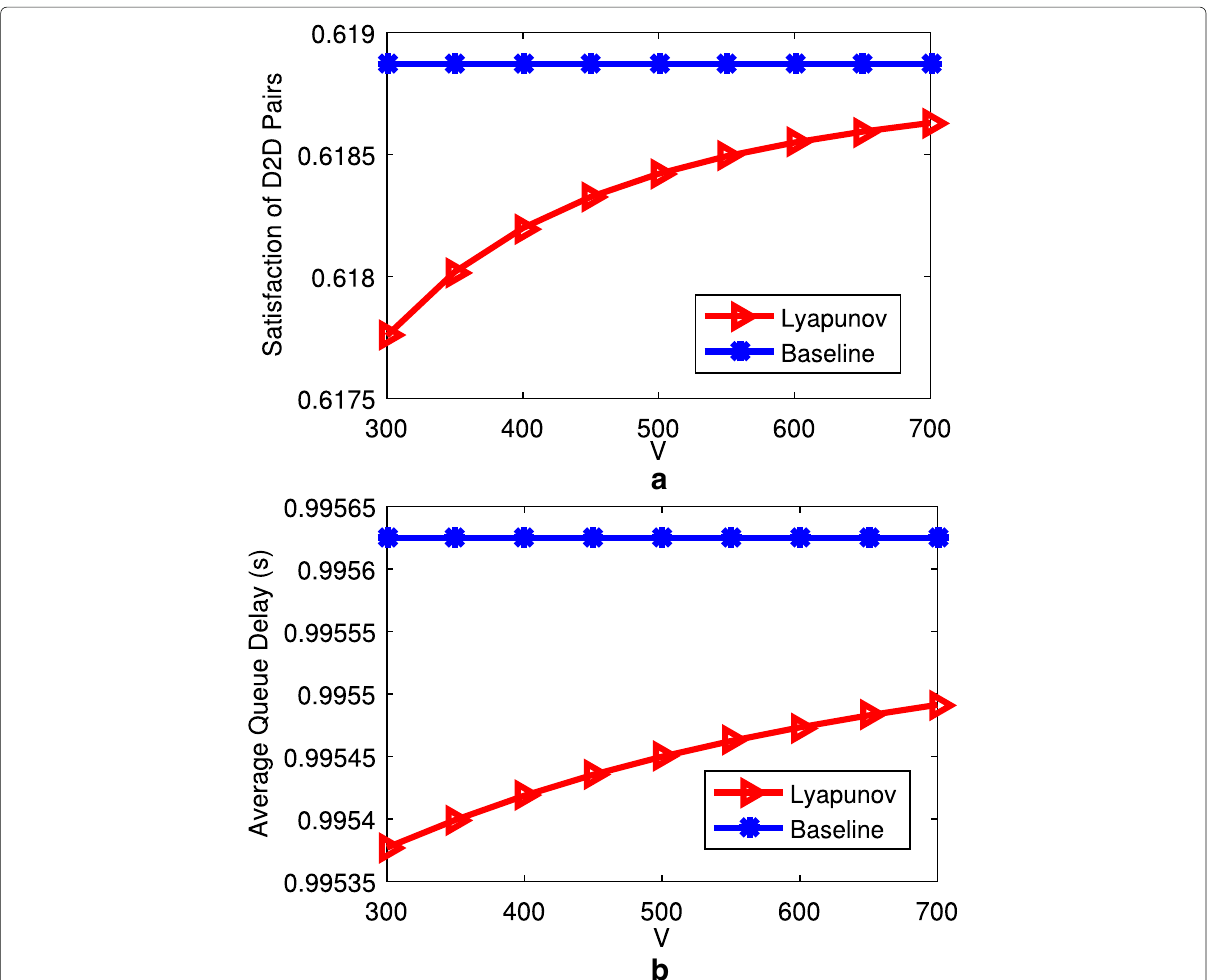
Fig. 4 a , b Satisfaction of D2D pairs and network delay versus control parameter